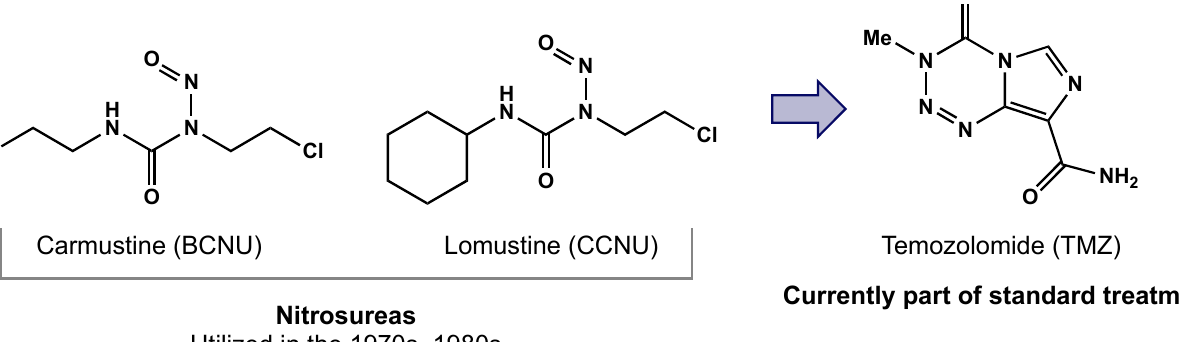
Figure 1. TMZ replacing nitrosoureas as the standard chemotherapy agent for GBM.